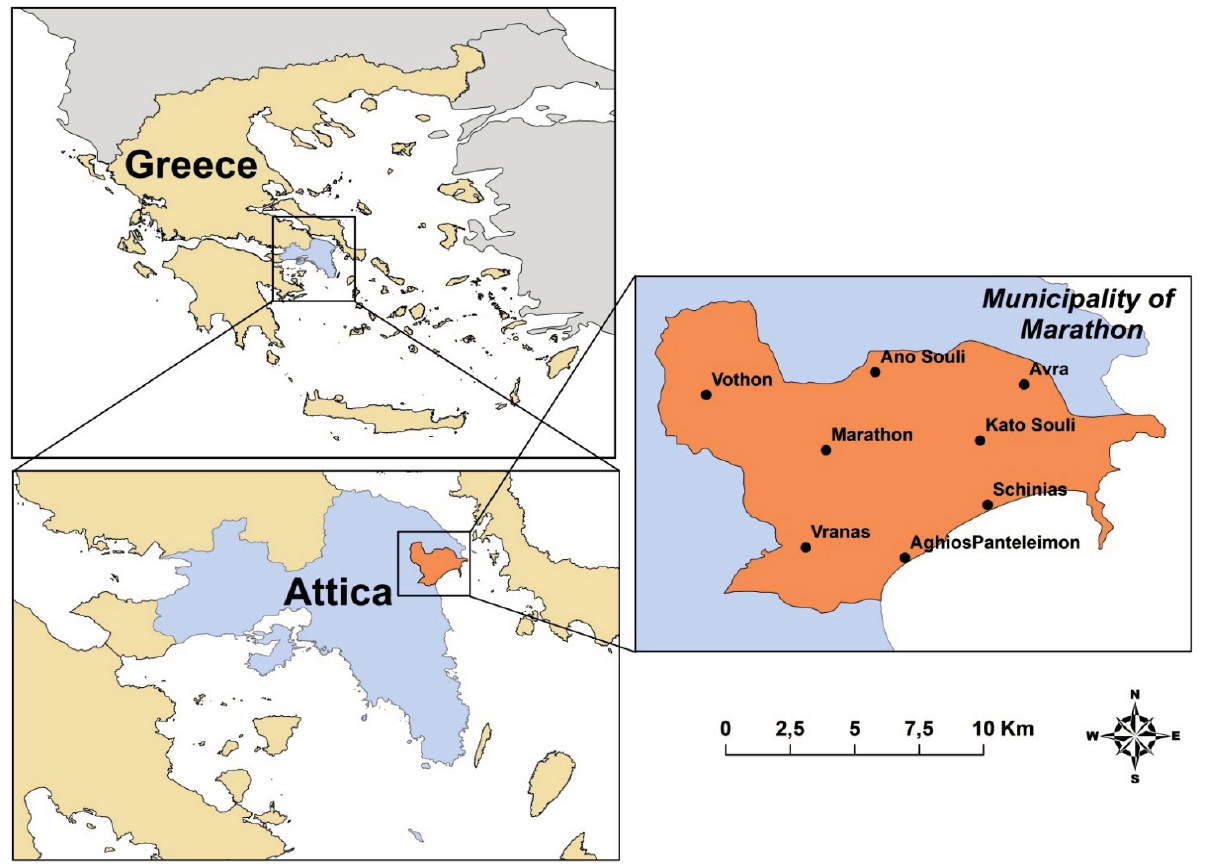
Figure 1. The study area (Marathon, Attica,